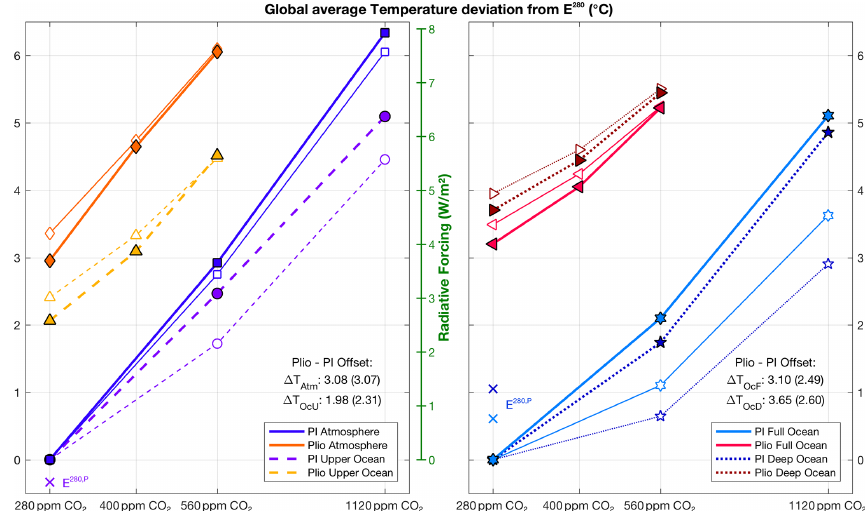
Figure 3. Overview of global average temperature in all of our different pre-industrial and Pliocene cases compared to the E 280 . Open mark- ers connected by thin lines show the time mean at the end of each simulation. Filled markers connected by thick lines show the corresponding equilibrium values. Cool colours are used for pre-industrial (PI) cases, and warm colours are used for the Pliocene (Plio) ones. We consider four different temperature measures: near-surface air temperature, upper-ocean, full-ocean, and deep-ocean area/volume weighted averages. Crosses indicate extrapolated temperatures from the E 280 , P case. Pliocene–pre-industrial offset values are given, determined by the mean temperature difference between cases at equal CO 2 (using a log interpolation between 280 and 560ppm to estimate the missing E 400 ). A similar offset, corrected for the difference between the E 280 and E 280 , P , is shown in